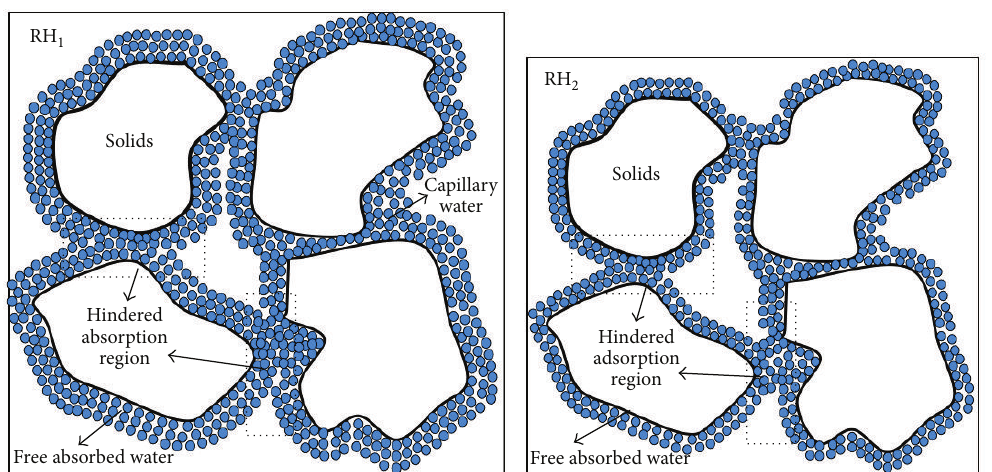
Figure 5: Schematic illustration of volumetric reduction due to change in surface free energy when desorption takes place (RH 2 < RH 1 ).